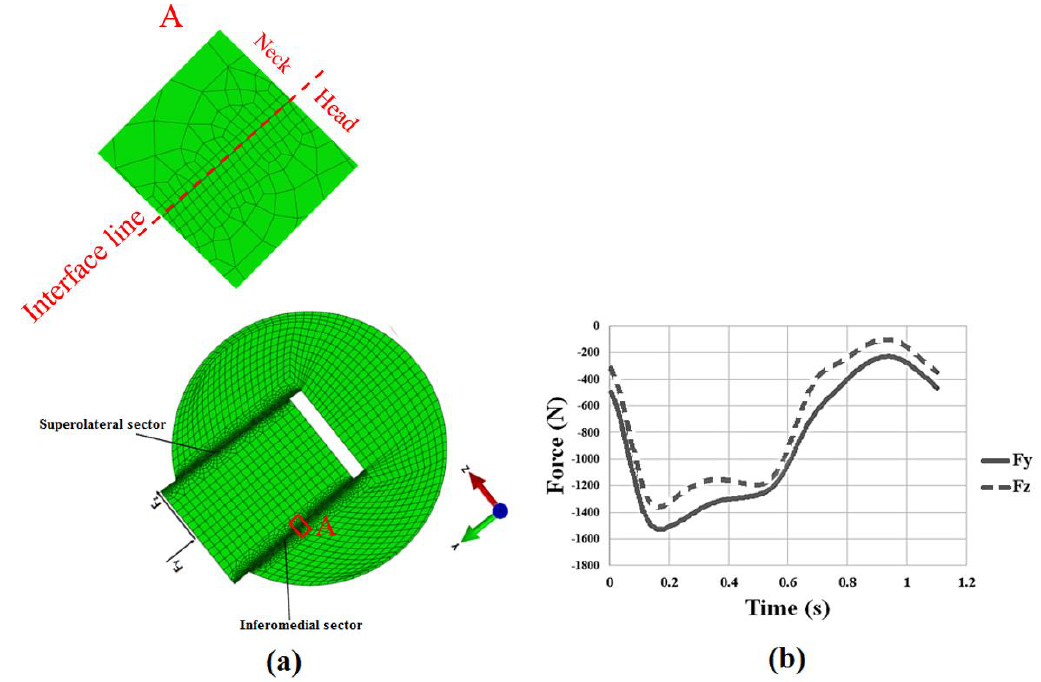
Figure 3. ( a ) Mesh structure of the 2D model of the most critical plane of the head-neck junction and ( b ) profile of corresponding forces in Y and Z axes from the normal walking gait cycle.